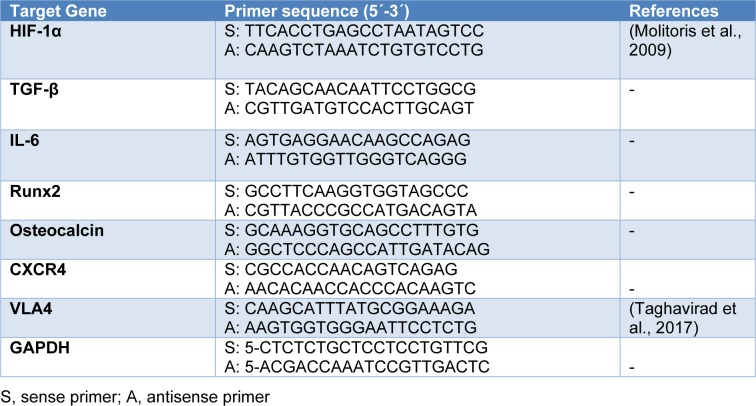
Primer sequences